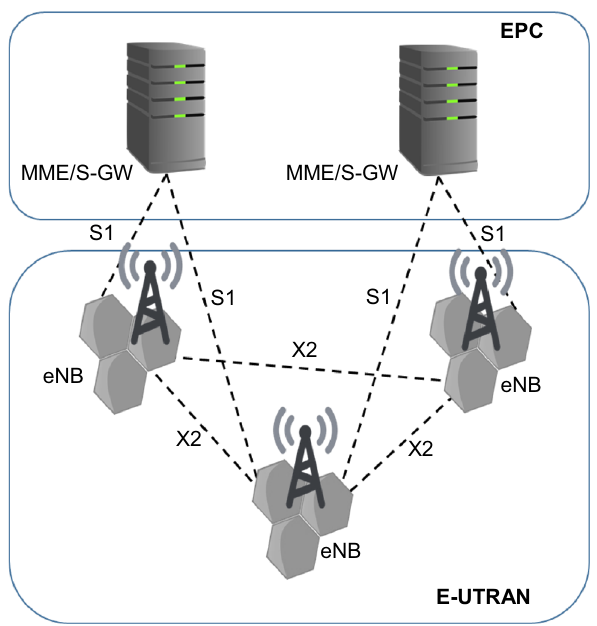
Fig. 1 LTE-Advanced network